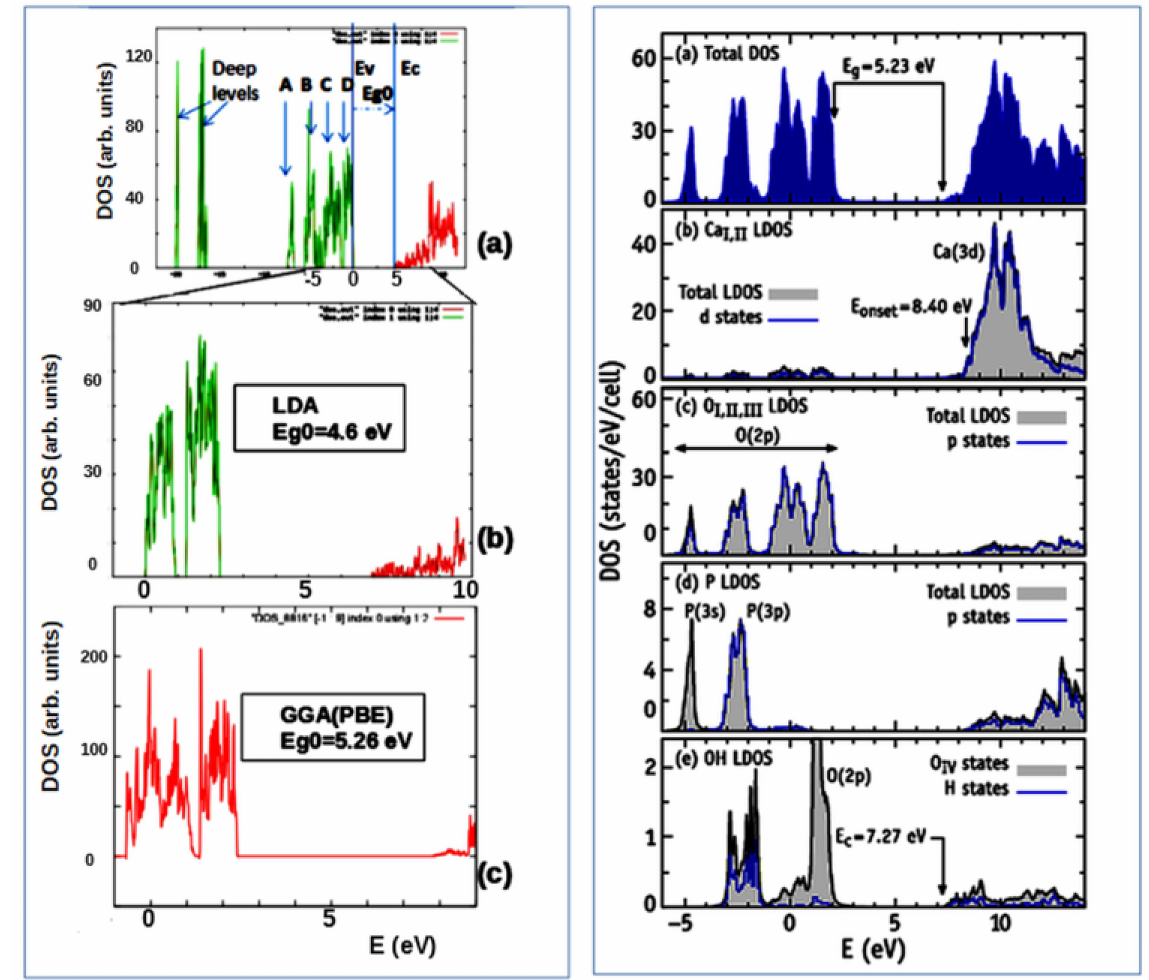
Figure 4. Left figures: Density of electronic states (DOS) for HAP unit cell: ( a ) Initial perfect stoichiometric HAP with 44 atoms in hexagonal P6 3 unit cell lattice, including deep levels and A,B,C,D peaks in valence band computed in LDA by AIMPRO; ( b ) the same with main energies around Eg; ( c ) the same computed in GGA (PBE) by VASP; (Data presented here obtained after calculations using AIMPRO (LDA) [38] and using VASP (PBE-GGA) [39]); Right figures: Total density of states of bulk HAP ( a ) and local densities of states projected on calcium ( b ), oxygen in PO4 units ( c ), phosphorous ( d ), and oxygen and hydrogen in OH units ( e ). In ( b – d ), the contribution to the LDOS with the dominant angular momentum is represented as a thick line. The results were obtained using the PBE exchange-correlation functional. (Adapted with permission from [7]; AIP Publishing,